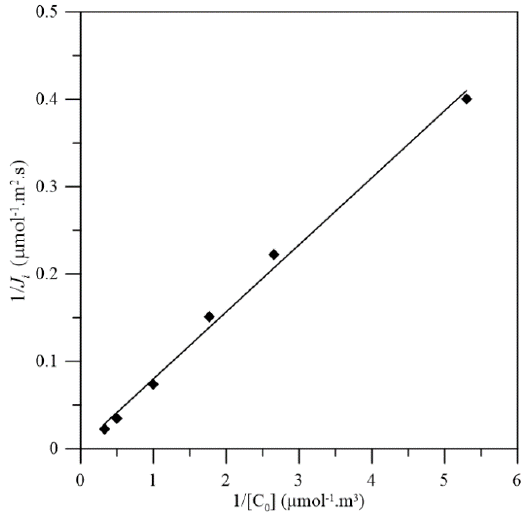
Figure 7. Plots of 1/ J f 0 vs. 1/[ C ] fo , for the transport of Cr(VI) across the Aliquat 336/PolyHIPE membrane. Feeding phase: pH 4; stripping phase: pH 12. Stirring rate: 450 rpm. membrane. Feeding phase: pH 4; stripping phase: pH 12. Stirring rate: 450